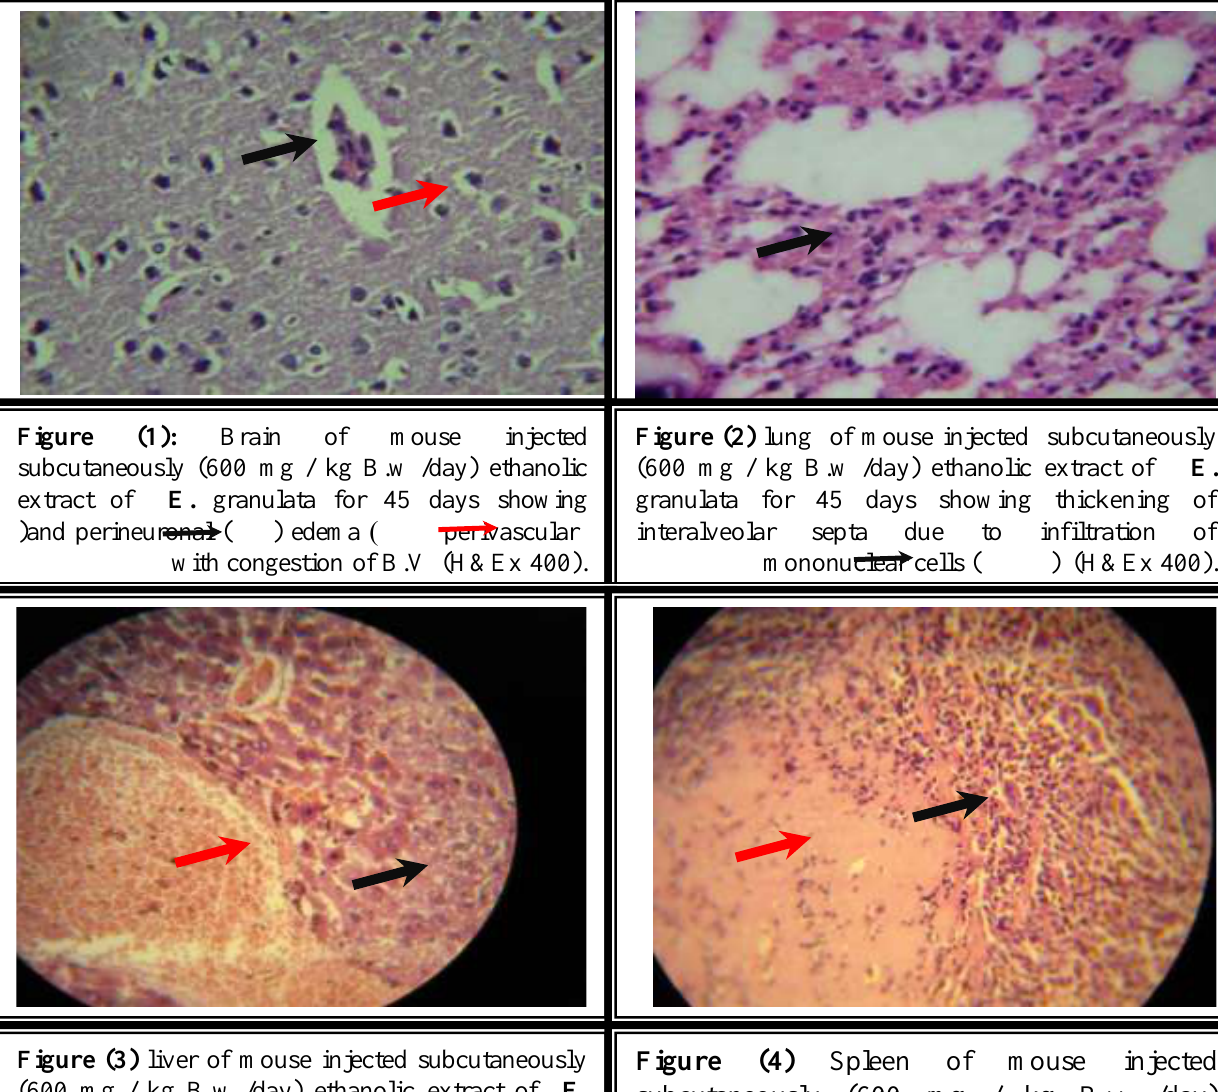
Figure (3) liver of mouse injected subcutaneously (600 mg / kg B.w /day) ethanolic extract of E. granulata for 45 days showing massive areas of necrosis with blood oozing to the necrotic area